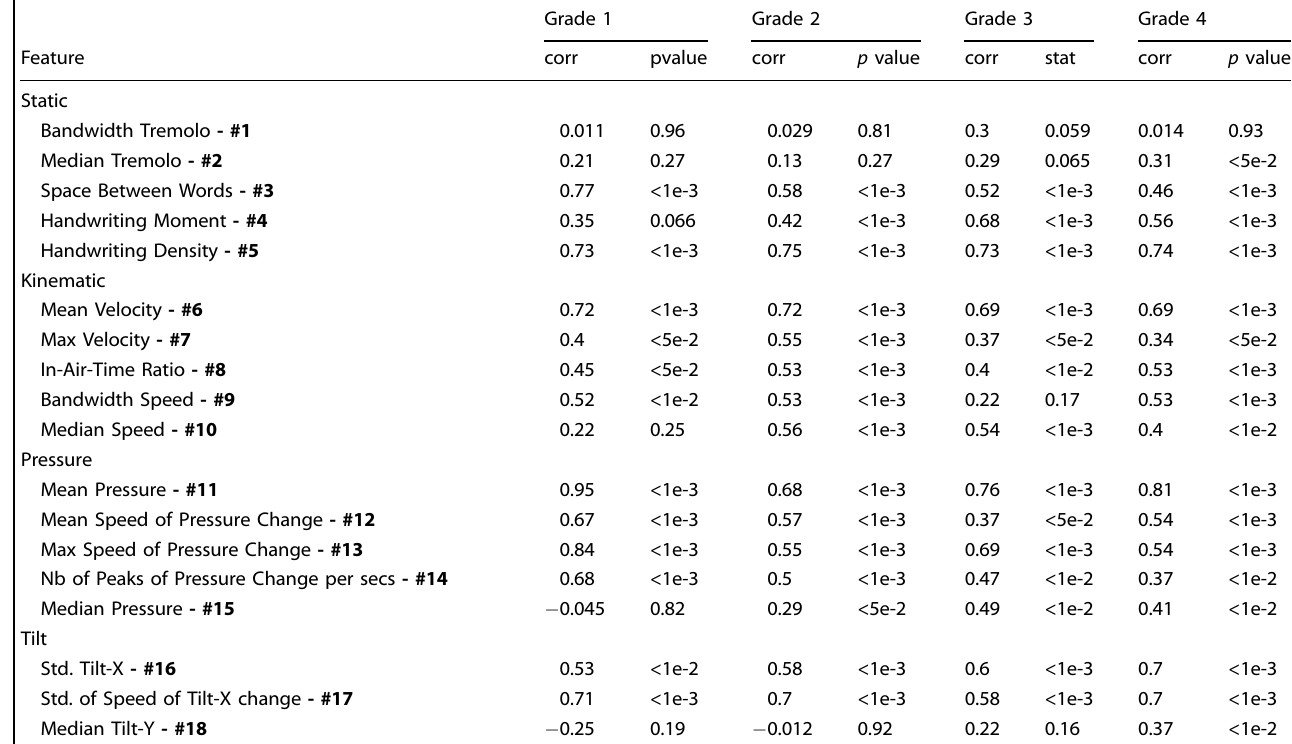
Table 2. Feature difference between the two alphabets (Cyrillic and Latin) for different